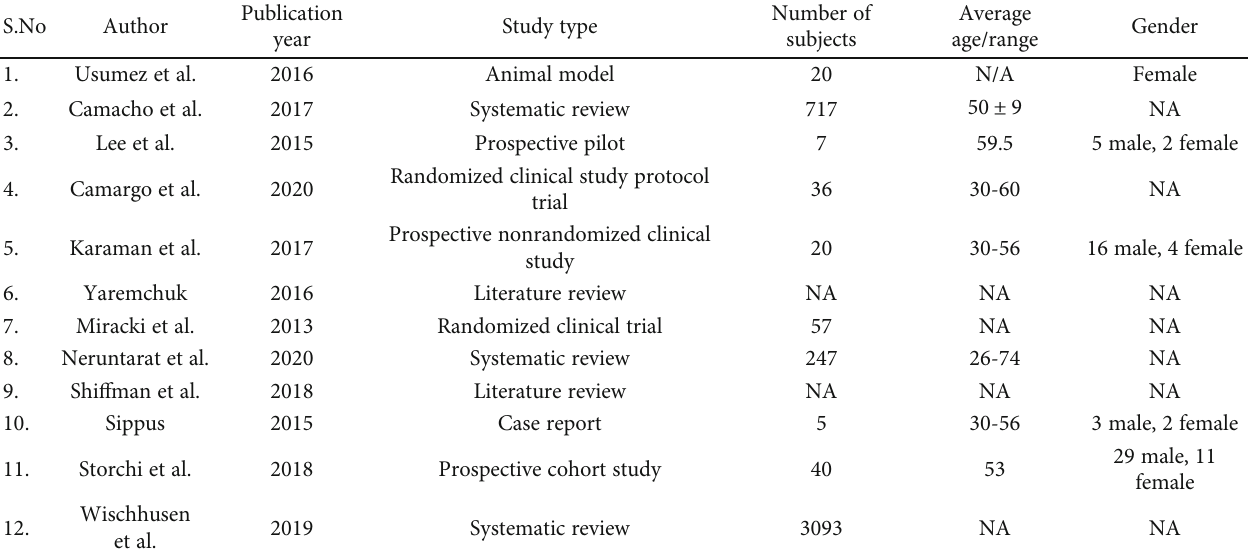
Table 3: Study subject demographics.